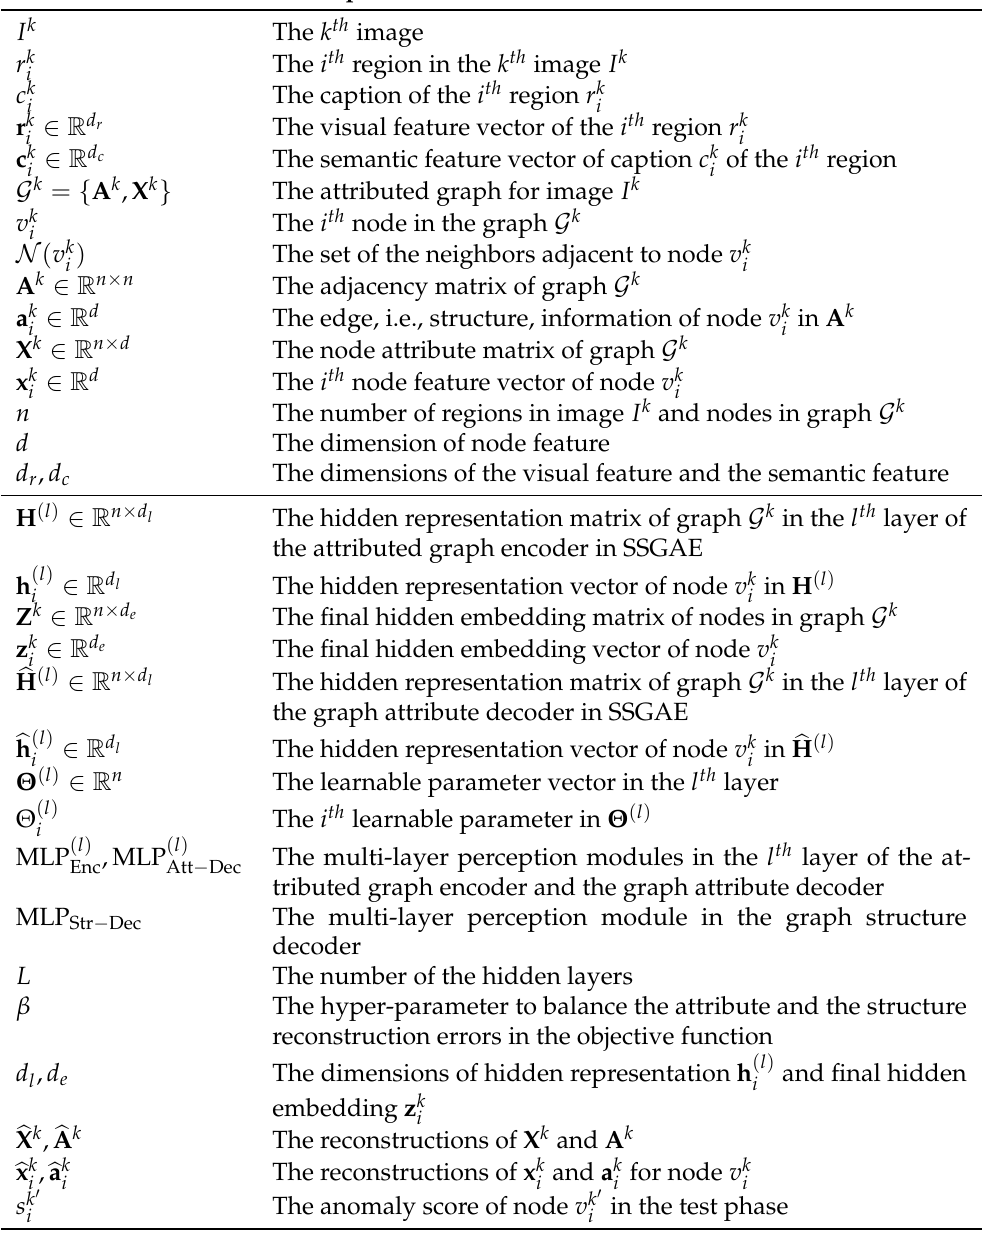
Table 1. Summary of notations and descriptions. The two blocks show the notations of variables for the graph and variables and parameters for